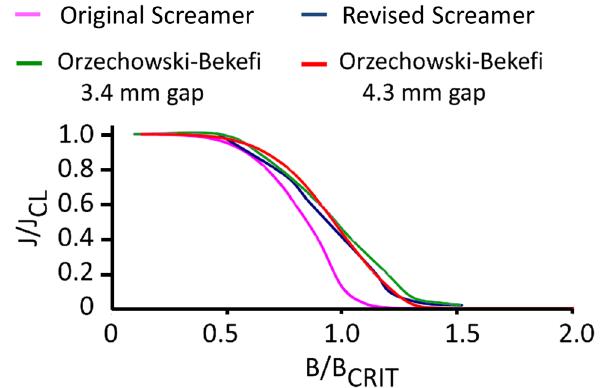
FIG. 7. The electron current density crossing the magnetic field (normalized to Child-Langmuir 1D space-charge-limited flow without a magnetic field) is shown as a function of the magnetic field at the anode B (normalized by the critical magnetic field anode for single particle magnetic insulation B ). Data from Orze- crit chowski and Bekefi at about 300 KVacross two different anode- cathode gaps are shown with the algorithm in the currently released version (original Screamer) and a slight modification used in this paper (revised